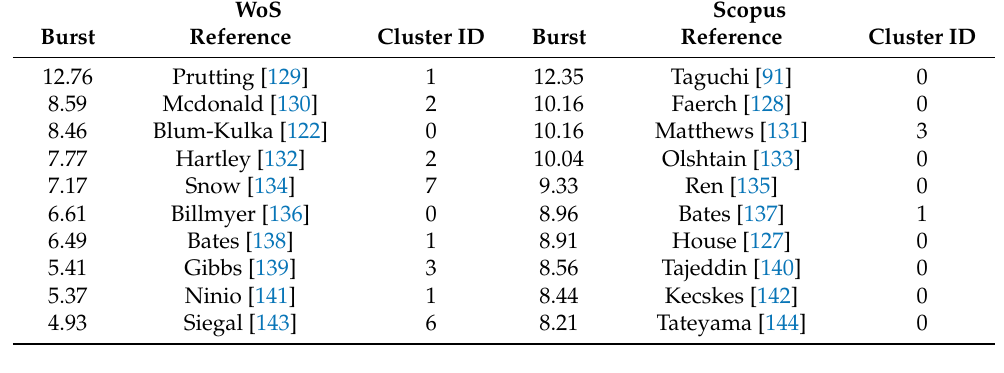
Table 8. Top bursts detected in pragmatic language development.